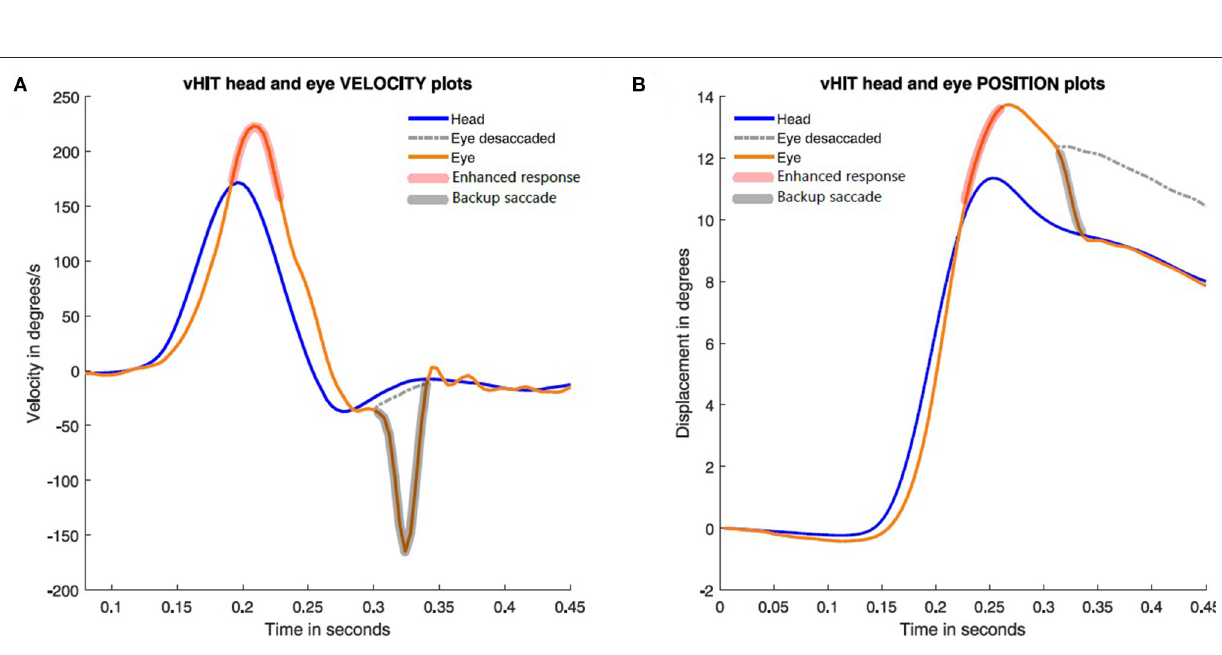
FIGURE 4 | Time series plots of eye velocity and corresponding eye position during a single rightward head impulse to show how the backup saccade corrects for the gaze position error. In (A) , the enhanced eye velocity (red shadow brush) is followed at the end of the head impulses by a backup saccade (black shadow brush). In (B) , head and eye position during the impulse are plotted. The dashed line shows eye position without backup